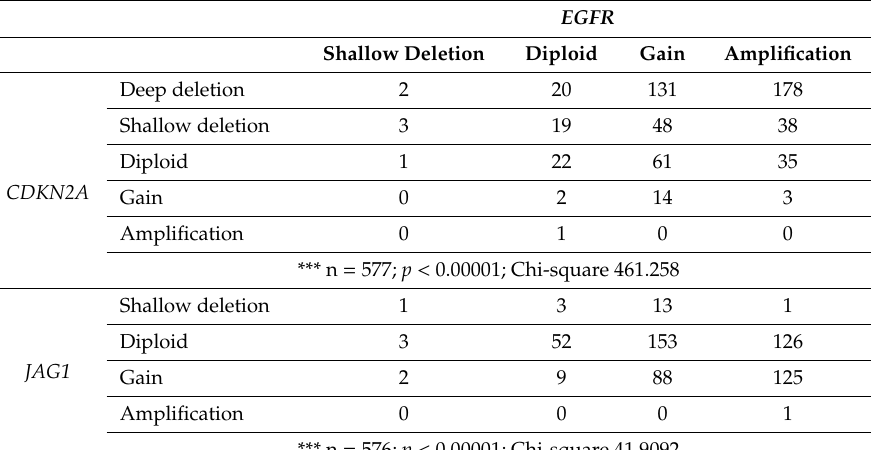
Table 2. Data from TCGA analysis performed using